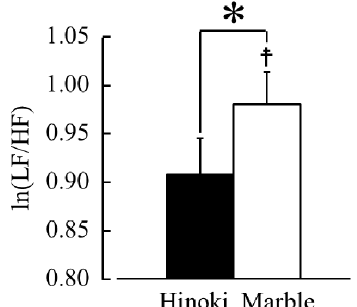
Figure 7. The natural logarithm of the low frequency/high frequency of heart rate variability during contact with materials via the soles of the feet. n = 19, mean ± SE, † p < 0.05 (pre-measurement vs. post-measurement value), * p < 0.05 (Hinoki vs. marble) as determined by using a paired t -test. However, no significant differences were found in the heart rate while touching Hinoki